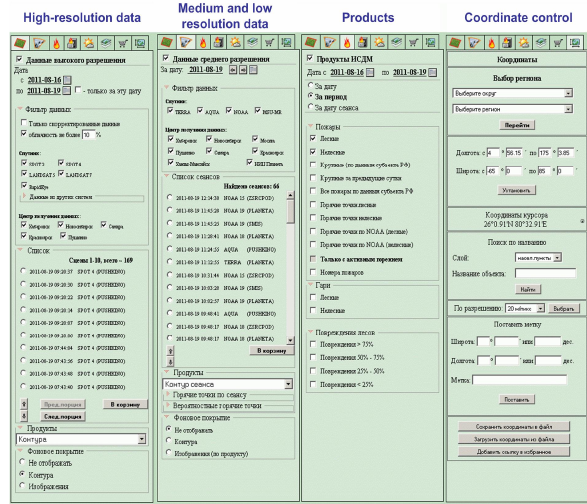
Fig.5. Typical tabs for UICU, providing data management. UICU also provides a special opportunity to select layers of different types for their detailed joint analysis. Selected layers (scenes, sessions, etc.) are collected in a separate tab, where depending on the task of particular realization of the interface certain operations can be applied to